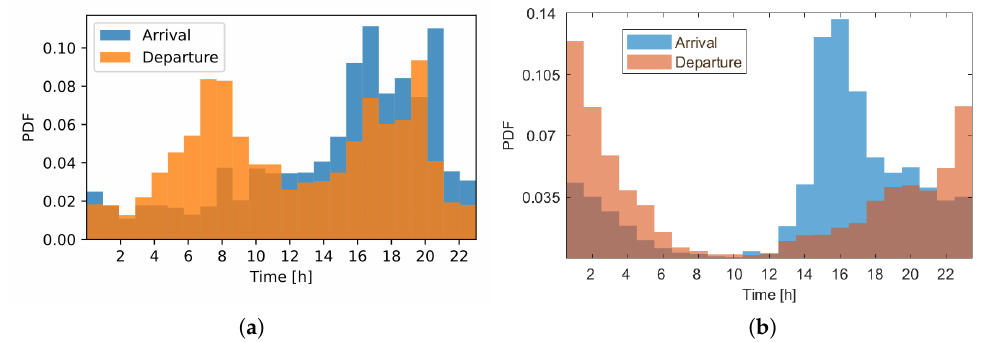
Figure 2. EV connection time information. ( a ) Pecan Street Dataport. ( b ) ACN-Data.